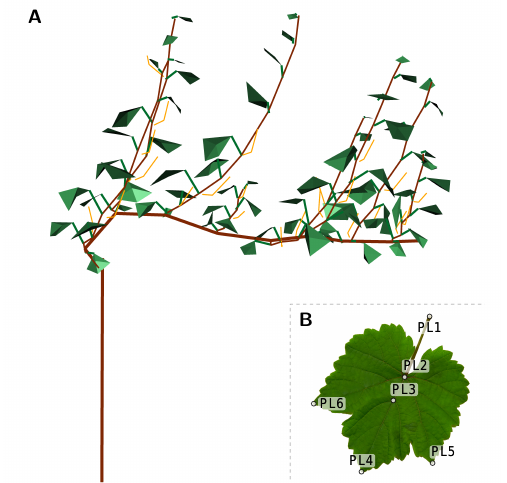
Figure 1. ( A ) Exemplary early-stage reconstructed digitised vine showing vine structure with single Guyot vertical shoot positioning system (VSP) with one cane pruned to approximately eight nodes (green: leaves; yellow: flowers; brown: cane/shoot); and ( B ) Riesling leaf digitisation scheme.